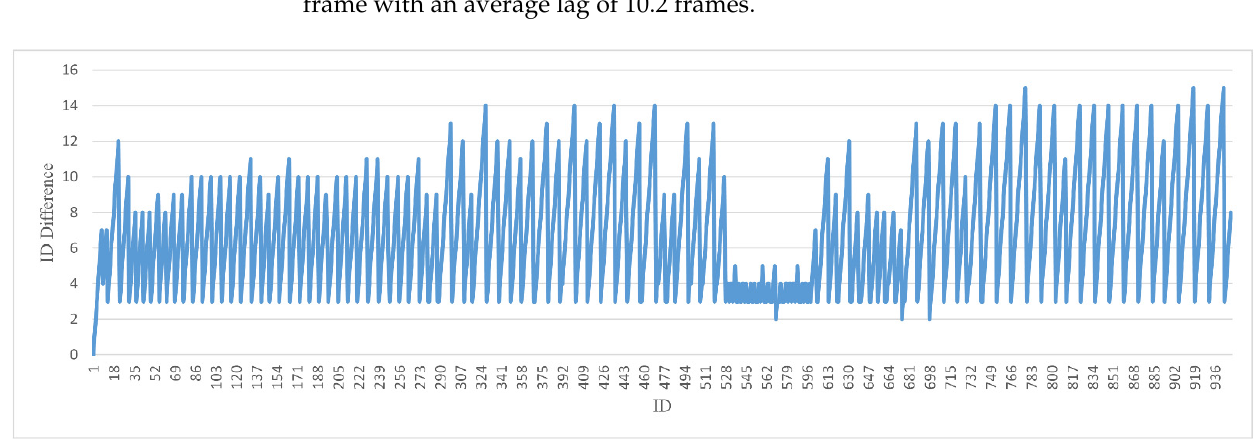
23 of 28 Table 4. Experimental results of rotational relative trajectory error. Sequences